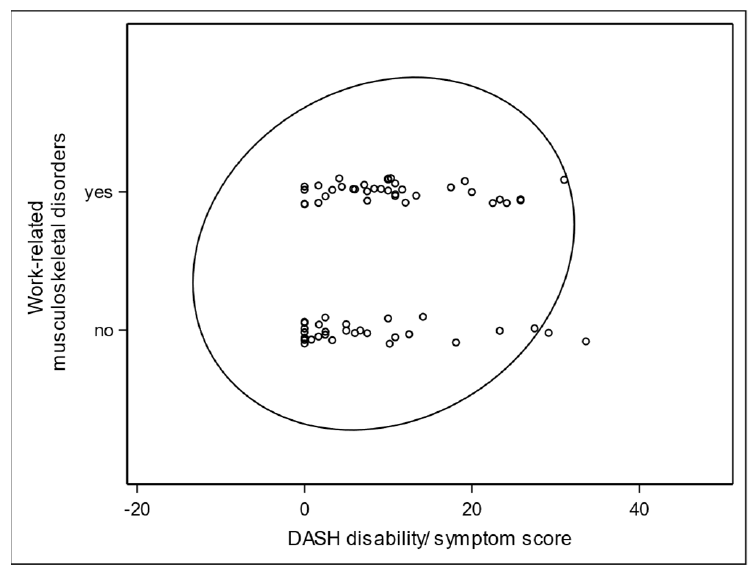
Figure 2. Prediction ellipse for graphical representation of the correlation between the DASH score and WMSD. Table 4. Correlation and confidence intervals between WMSDs and other clinical endpoints.